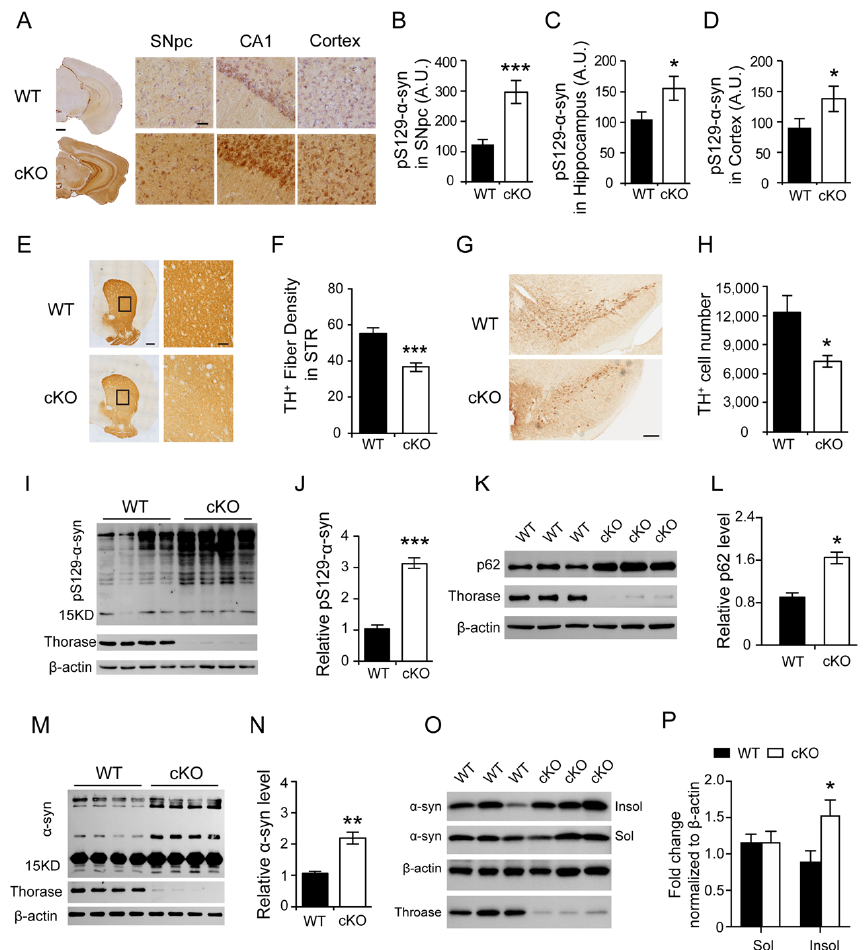
Figure 2. Thorase cKO mice exhibit extensive α -syn accumulation in the brain. ( A ) Immunohisto- chemical staining of pS129- α -syn in the brains of Thorase cKO and WT littermate mice at the age of 5 months. Scale bar, 1 mm. High-powered view of pS129- α -syn immune reactivity in the substantia nigra (SNpc), hippocampal CA1 region (CA1) and cortex. Scale bar, 25 μ m. Anti- α -syn (phospho S129) antibody (Abcam, 1:1000). ( B – D ) Quantified pS129- α -syn optical density (OD) in the SNpc ( B ), hippocampus ( C ) and cortex ( D ) (n = 6). ( E ) Representative images of TH immunostaining using anti-TH antibody (Novus, 1:1000) in striatum region (STR) sections from Thorase cKO and WT lit- termate mice at the age of 5 months. Black rectangles represent for the corresponding right images of high magnification. Scale bars, 500 μ m for low magnification and 100 μ m for high magnification. ( F ) Quantification of TH+ fibers in the STR from Thorase cKO and WT littermate mice (n = 4). ( G ) Representative images of TH immunostaining using anti-TH antibody (Novus, 1:1000) in substantia nigra pars compacta (SNpc) regions in Thorase cKO and WT littermate mice at the age of five months. Scale bar, 200 μ m. ( H ) Quantification of TH+ neurons in the SNpc regions of Thorase cKO and WT littermate mice from three independent experiments (n = 4). ( I ) Western blots showing the detection of pS129- α -syn levels in the brains of Thorase cKO and WT littermate mice. Anti- α -syn (phospho S129) antibody (Abcam, 1:1000); anti-Thorase (Biolegend, 1:1000); anti- β -actin antibody (BOSTER, 1:2000). ( J ) Quantification of the integral optical density (IOD) of pS129- α -syn normalized to β -actin (n = 10). ( K ) Western blots showing the detection of p62 levels in the brains of Thorase cKO and WT littermate mice. Anti-SQSTM/p62 antibody (MBL, 1:2000). ( L ) Quantification of the integral optical density (IOD) of p62 normalized to β -actin (n = 8). ( M ) Western blots showing α -syn in the brains of Thorase cKO and WT littermate mice at the age of 5 months. Anti- α -syn antibody (BD, 1:1000). ( N ) Quantification of α -syn normalized to β -actin experiments (n = 6). ( O ) Western blots showing the detection of TX-insoluble α -syn and TX-soluble α -syn levels in the brains of Thorase cKO and WT littermate mice. Anti- α -syn antibody (BD, 1:1000). ( P ) Quantification of the integral optical density (IOD) of Triton X-insoluble α -syn and Triton X-soluble α -syn normalized to